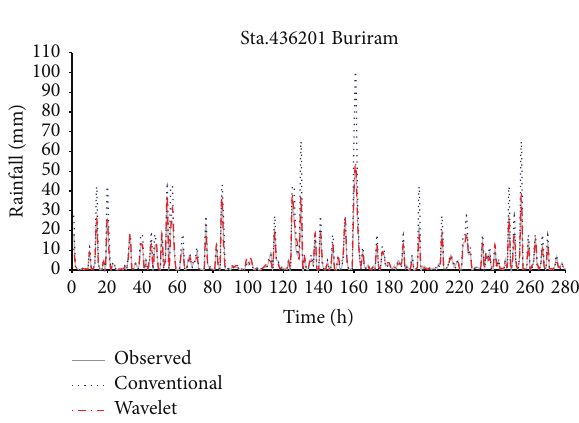
Figure 16: Time series plot of mean observed rainfall at sta.436201 Buriram compared with conventional and wavelet filters technique.